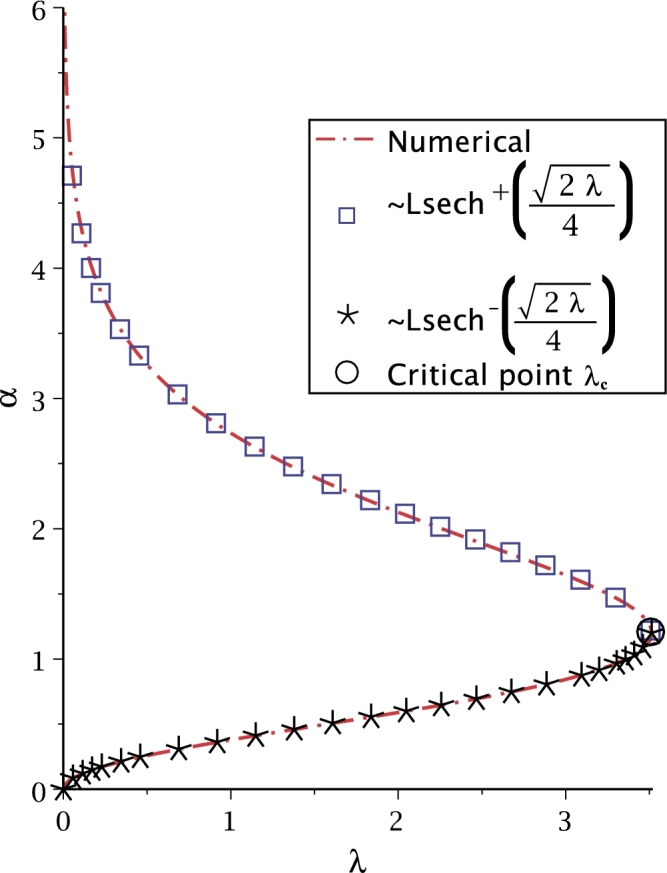
Comparison between (37) and (38).